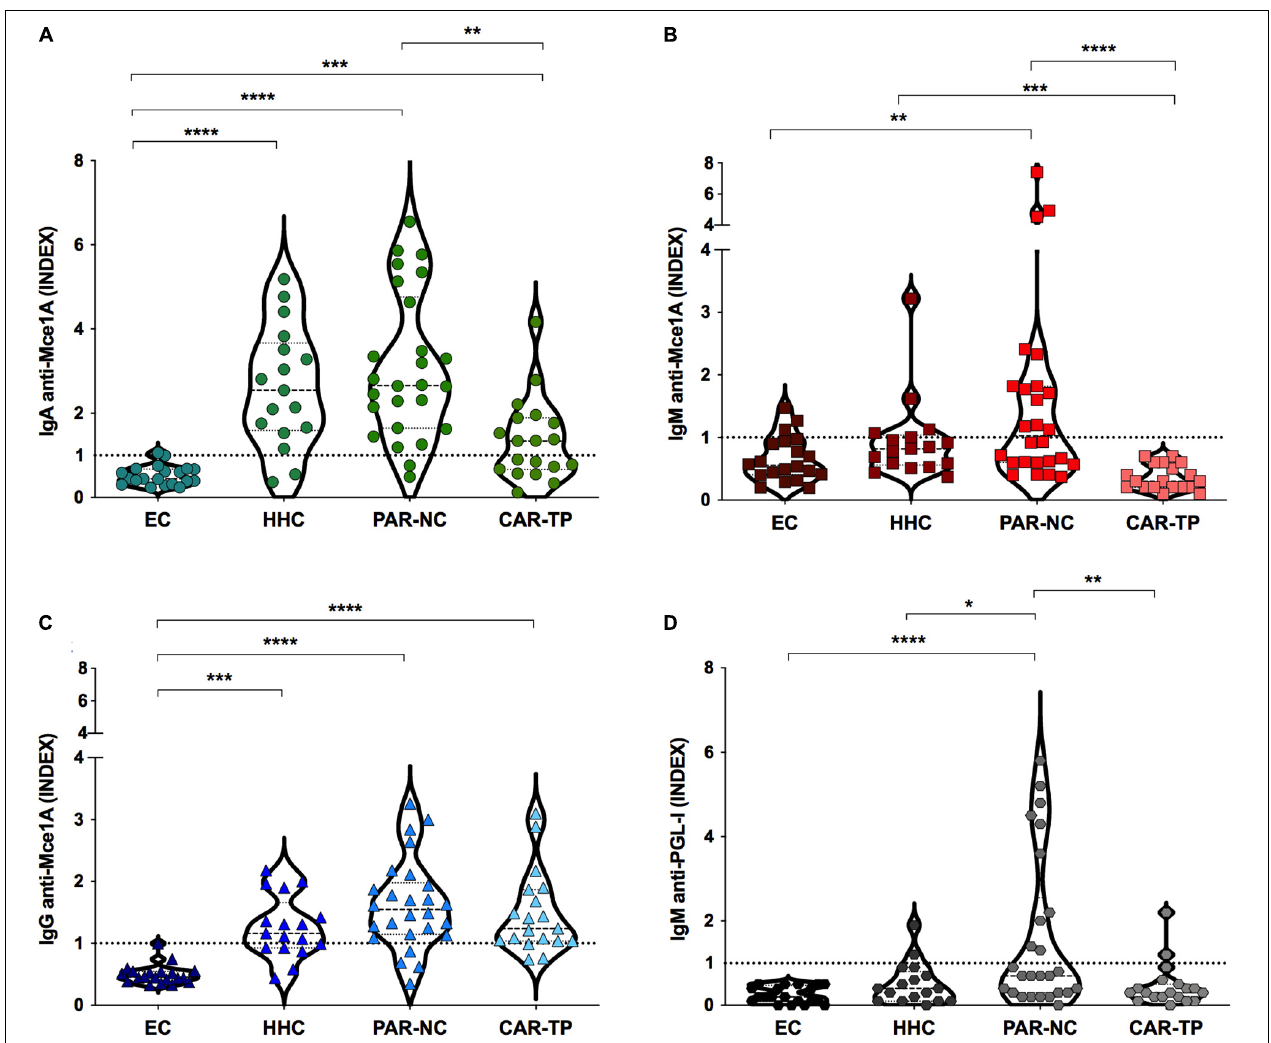
FIGURE 1 | Antibodies anti-Mce1a are biomarkers for the diagnosis and monitoring of HD. IgA (A) , IgM (B), and IgG (C) antibody indices against Mce1A protein and PGL-I (D) in different groups of plasma samples tested. Statistical significance was determined by the Kruskal–Wallis test followed by the Dunn test. Data are presented as the median and interquartile range (IQR); significance was considered at p < 0.05, p < 0.01, p < 0.001, or p < 0.0001 as represented by *, **, ***, and ****, respectively. EC endemic controls ( n = 20); HHC household contacts of HD patients in Parnaíba ( n = 17); PAR-NC new cases of HD in Parnaíba ( n = 26); CAR-TP patients treated in Colony Carpina ( n = 19). The respective index was calculated by dividing the optical density (O. D 450 nm) of each sample by the cut-off, and indices above 1.0 were considered positive represented by horizontal dotted line.